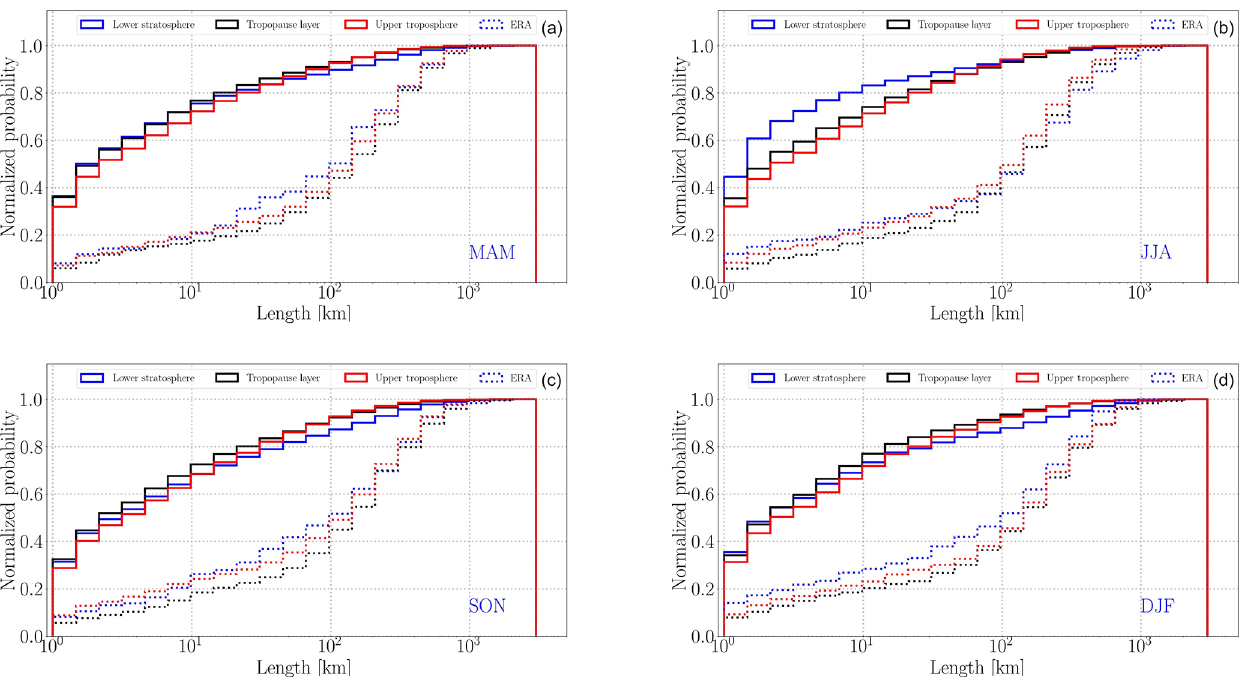
Figure 10. Seasonal cycle of ISSRs for lower stratosphere (blue), tropopause (black) and upper troposphere (red). Dashed lines show results for ERA. Panels (a) and (b) represent spring and summer months; (c) and (d) represent fall and winter months, respectively. Table 6. Number ( N ), mean and median of ISSR pathlengths L (km) for the upper troposphere, tropopause and lower stratosphere for the MAM, JJA, SON and DJF